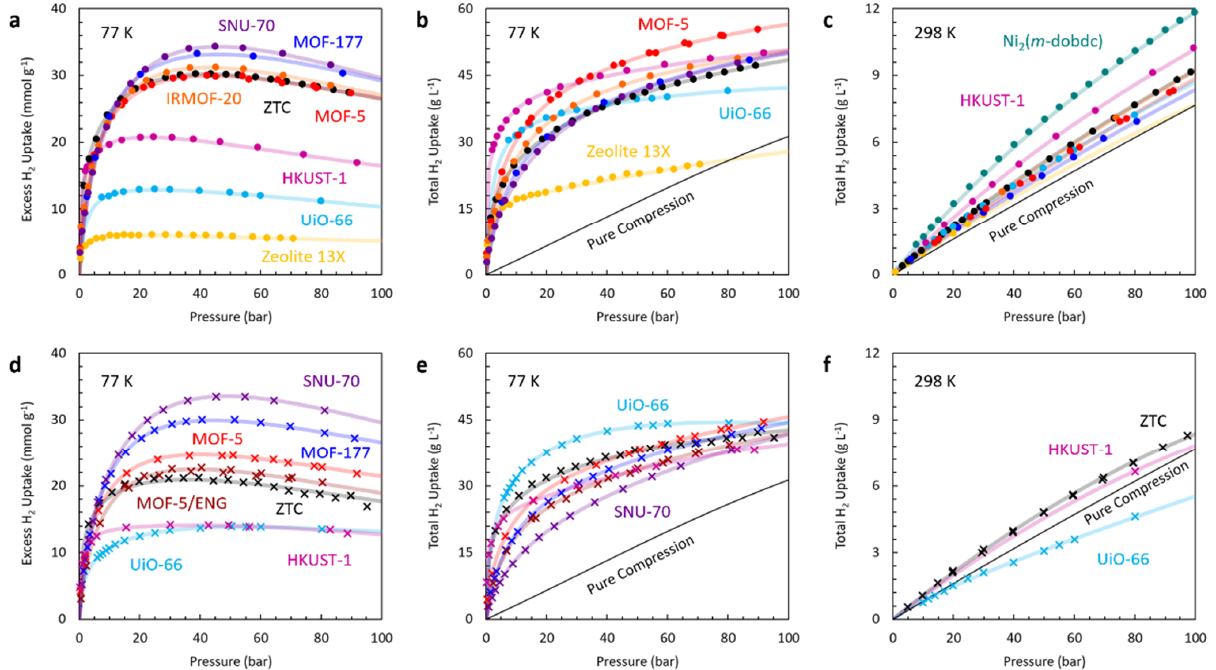
Figure 5. Equilibrium H 2 adsorption uptake on ( a – c ) benchmark crystals and ( d – f ) benchmark pellets/monoliths at 77 and 298 K. Excess H 2 adsorption data were obtained from the following references: ZTC [98], MOF-5 [36], MOF-177 [53], IRMOF-20 [32], SNU-70 [32], UiO-66 [101], HKUST-1 [99], Ni 2 ( m -dobdc) [102], and zeolite 13× [87] powders, and ZTC/rGO pellet (0.67 g mL −1 ) [57], MOF-5 neat pellet (0.52 g mL −1 ) [37], MOF-5/ENG pellet (5% ENG, 0.47 g mL −1 ) [37], MOF-177 pellet (0.39 g mL −1 ) [53], SNU-70 compact (0.24 g mL −1 ) [32], HKUST-1 pellet (0.86 g mL −1 ) [103], and UiO-66 pellet (1.45 g mL −1 ) [101]. The crystalline assumption was employed for all crystals ( a – c ), the skeletal assumption for all pellets ( d – f ).